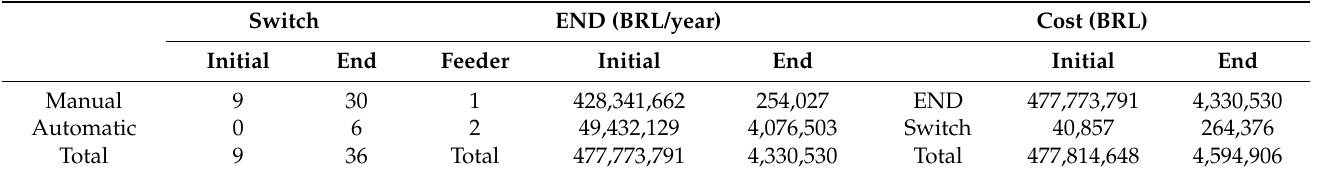
Table 4. Key information and costs for the 43-bar network.